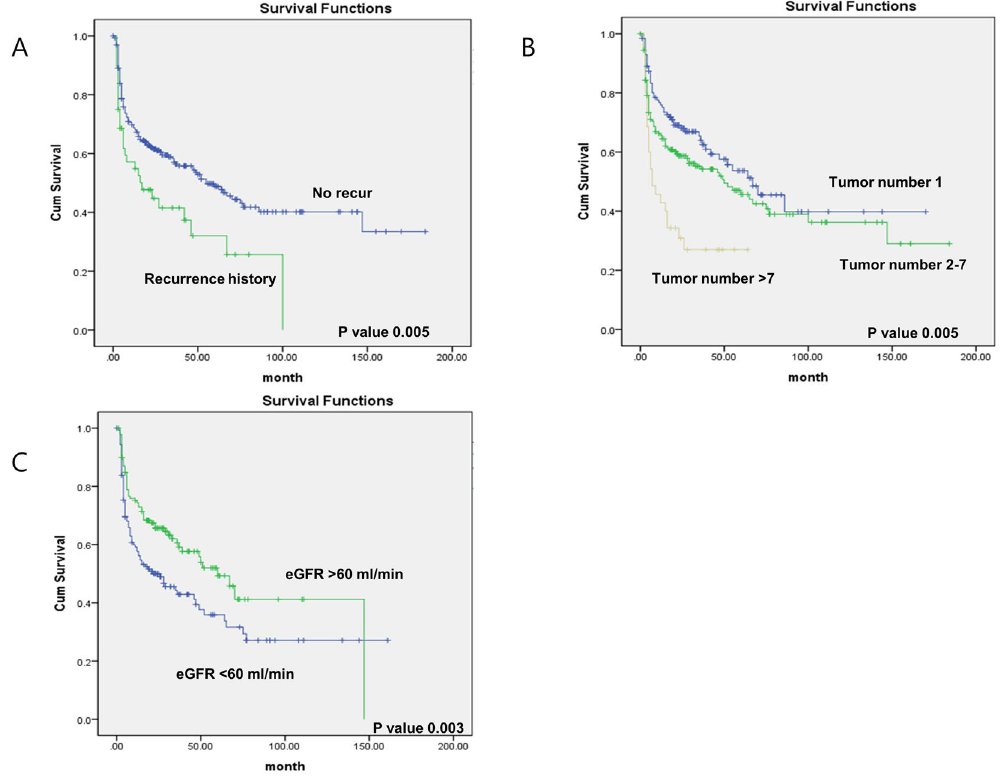
Figure 1. Probability of bladder cancer recurrence-free survival in 344 patients treated with intravesical BCG instillation for NMIBC; Stratified by predictors for recurrence. History of recur ( A ), Tumor number ( B ), Renal function ( C